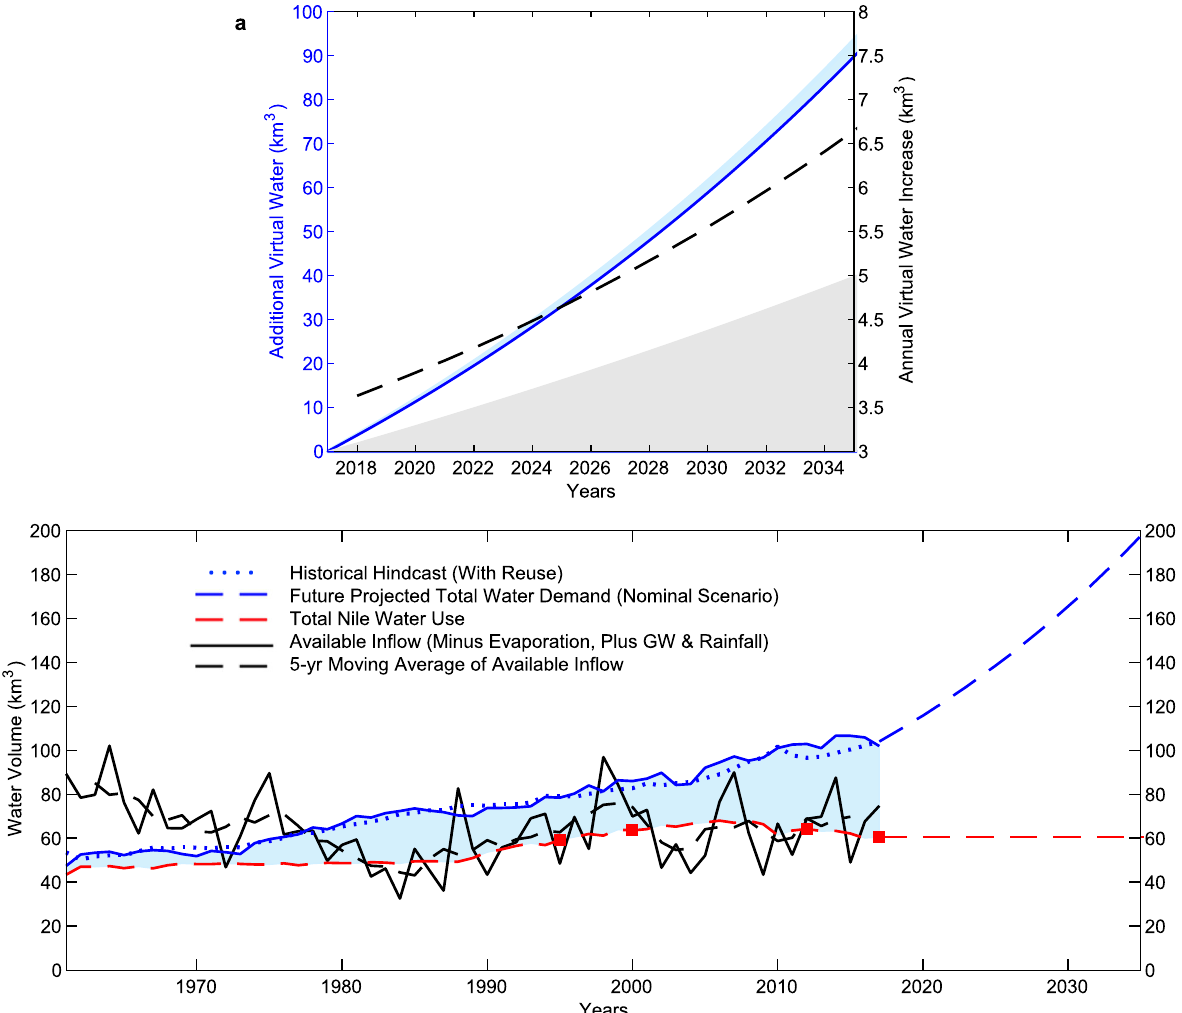
Fig. 6 Future scenarios. a Additional Virtual Water Demand (km 3 ) [blue line] and Annual Increase Rate (km 3 ) [black dotted line] for a nominal growth scenario (1.7% population growth, 2.3% GDP per capita growth) versus 2017 levels. Light blue shading represents the increased municipal water demand. Gray shading represents the additional virtual water imports in a 0% GDP growth, 1.7% population growth scenario. b Historical hindcast of total water use paired with the nominal projections of total water needed in panel a . The blue dotted line shows the total hindcasted water use, including ef fi ciency scaled total agricultural demand, municipal use and industrial use, and reuse. This is compared to the sum of historical virtual water imports [blue shading] and the total Nile use estimate [red dashed line] and is shown as the solid blue line. Future projections are divided between in-country consumption [red dashed line] and increased virtual water demand [area between red dashed line and blue dashed line]. Future Projected Total Water Demand is shown by blue dashed line. Red squares mark total Nile use estimate for 1995, 2000, 2012, and